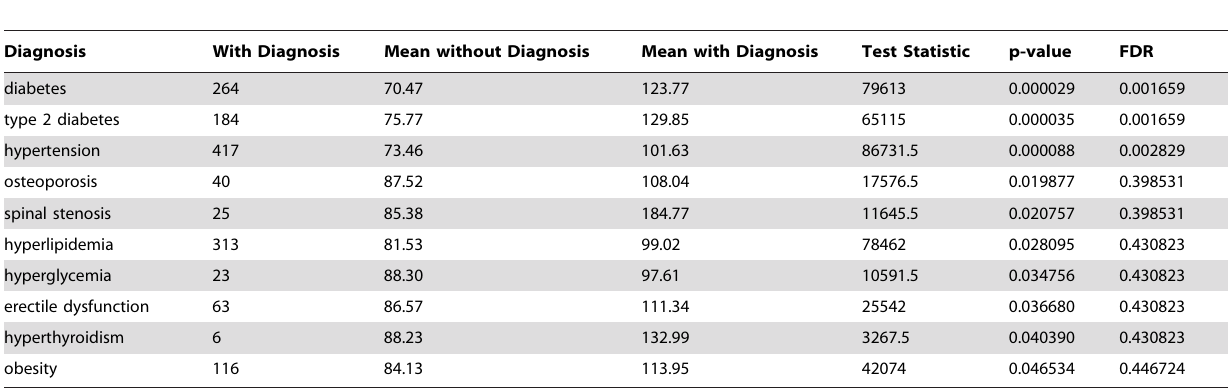
Table 5. Univariate association of common phrases from the patient history coded for patients from the primary care facility data set with Cthrc1.